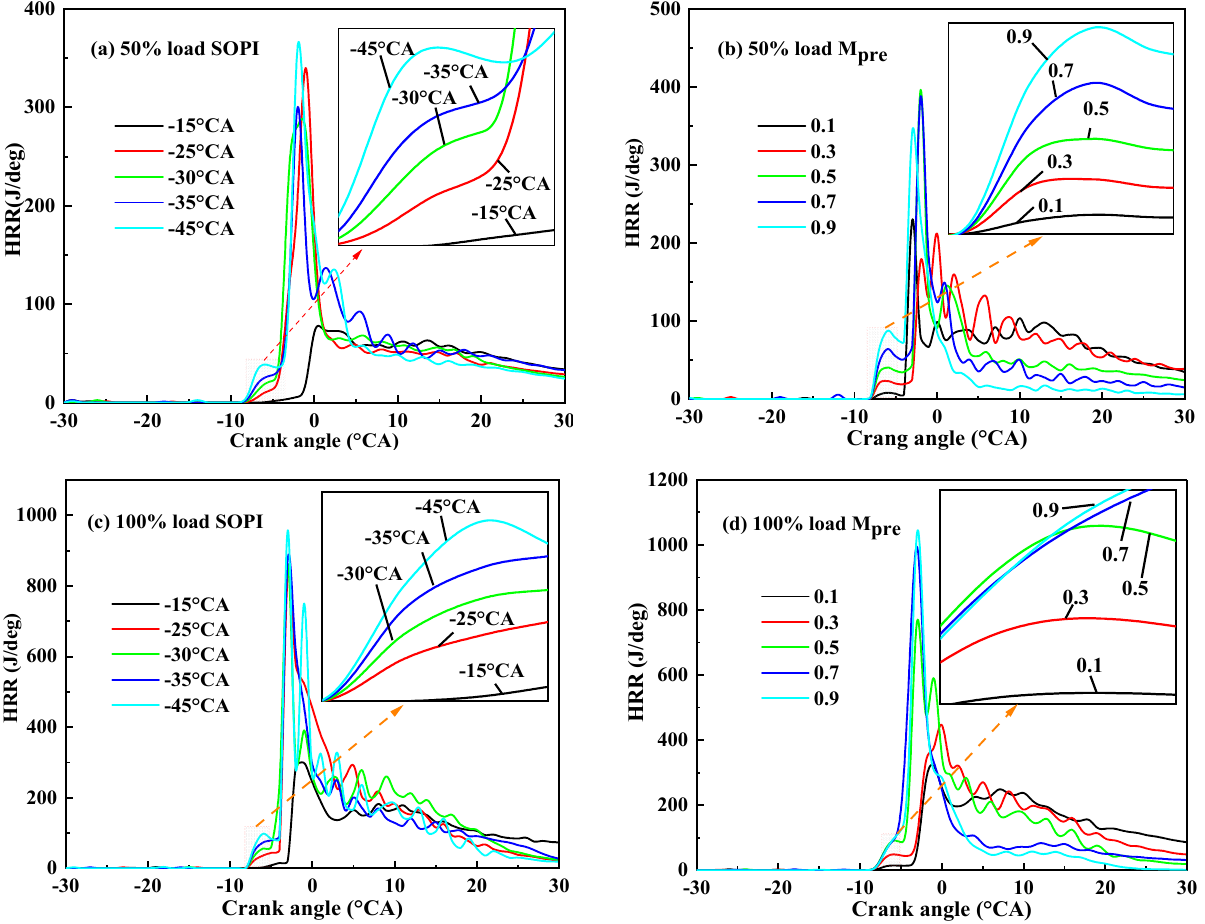
Figure 8. Comparison of HRR under different load conditions.